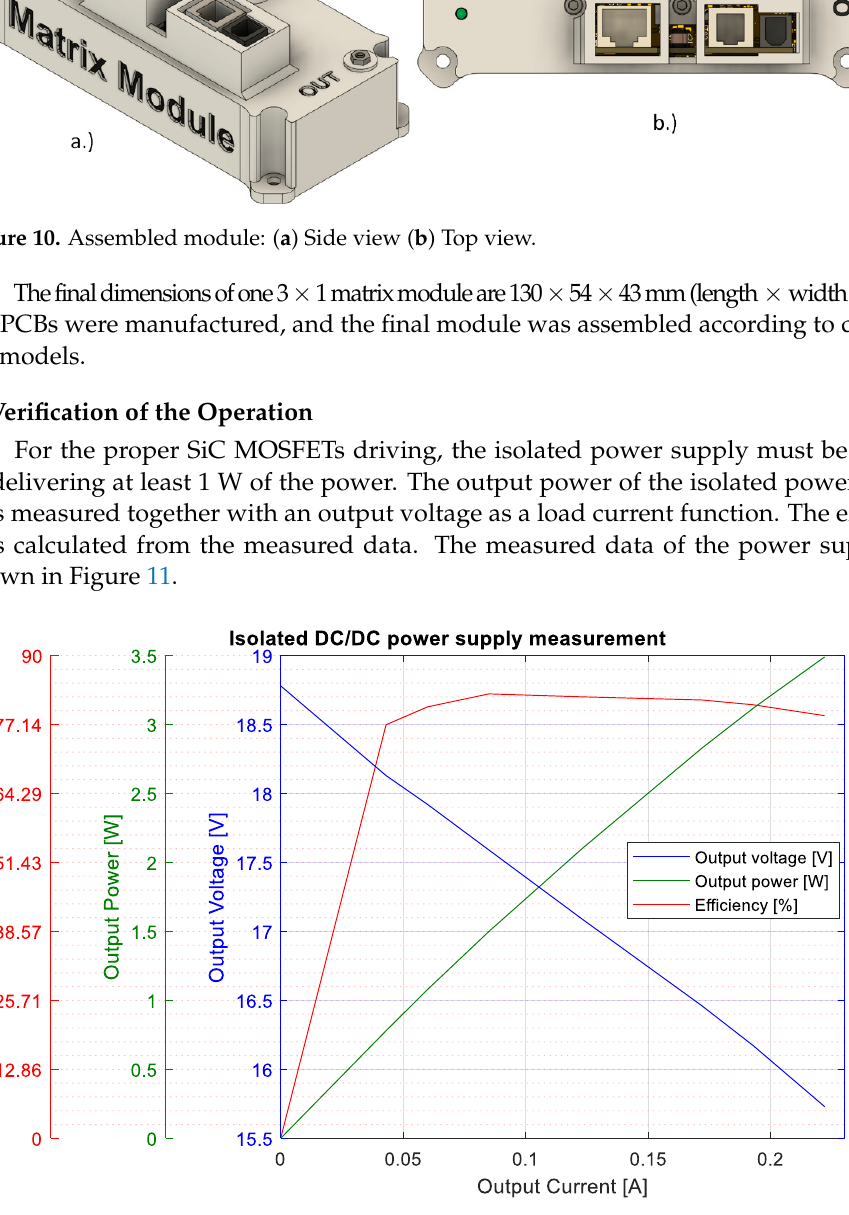
Figure 11. Measured characteristics of the designed isolated power supply. As shown in Figure 11, the operating output power of approximately 1 W to 2 W converter reaches its maximum efficiency of around 82%. The converter can deliver more power in case if more powerful semiconductors are used. The output current is limited to 200 mA due to the used secondary rectification diode limitation. The thermal image of the one power supply during the output load of 2 W can be seen in Figure